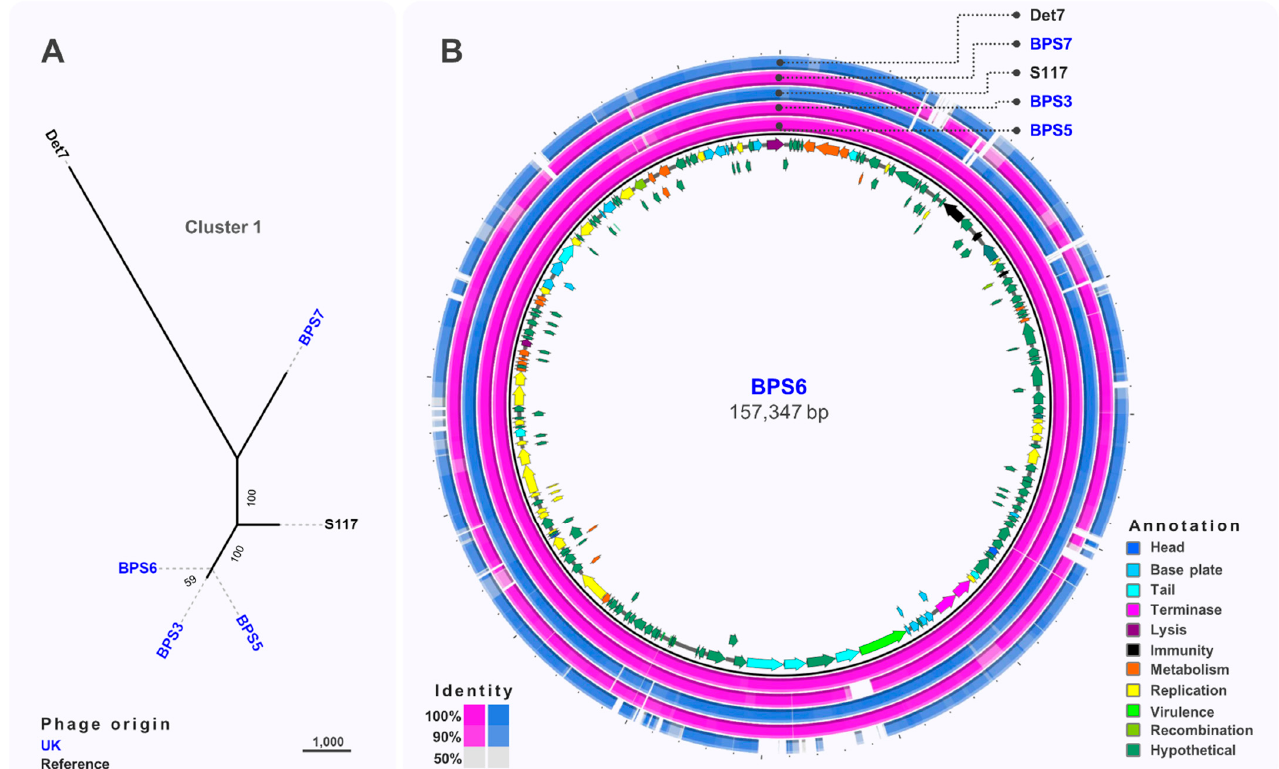
Figure 3. Comparative genomics of phages from Cluster 1. ( A ) Maximum-likelihood tree of phages in Cluster 1, unrooted and visualised in iTOL with numbers on branches indicating bootstraps. Scale bar represents number of single nucleotide polymorphisms. Phage names in blue were isolated from the UK and black font indicates reference phages. ( B ) Whole- genome comparison of phages in Cluster 1. The local similarity of each genome at the nucleotide level was calculated based on BLASTn high scoring pairs and plotted against a circular map of BPS6 represented as the inner circle. Blue circles represent reference genomes. Genome annotation is shown as arrows in the inner circle, colour-coded based on gene categories. Full annotation can be found in Table S2.